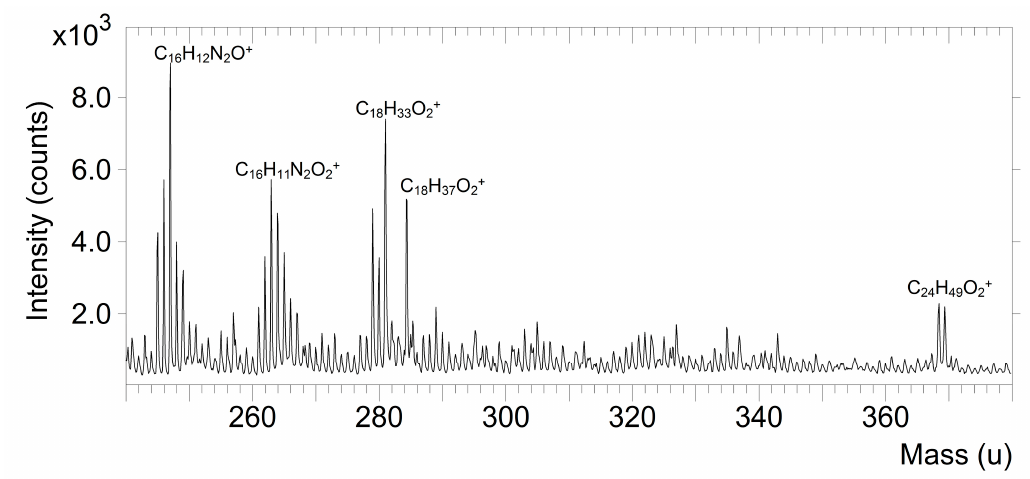
Figure 5. Part of the positive ion mass spectra extracted from the blue area and showing indigotin protonated ion (C 16 H 11 N 2 O 2+ , m/z 263), indigotin fragment ion (C 16 H 11 N 2 O + , m/z 247), and protonated fatty acids: linoleic (C 18 H 33 O 2+ , m/z 281), stearic (C 18 H 37 O 2+ , m/z 285), and lignoceric (C 24 H 49 O 2+ , m/z 369).